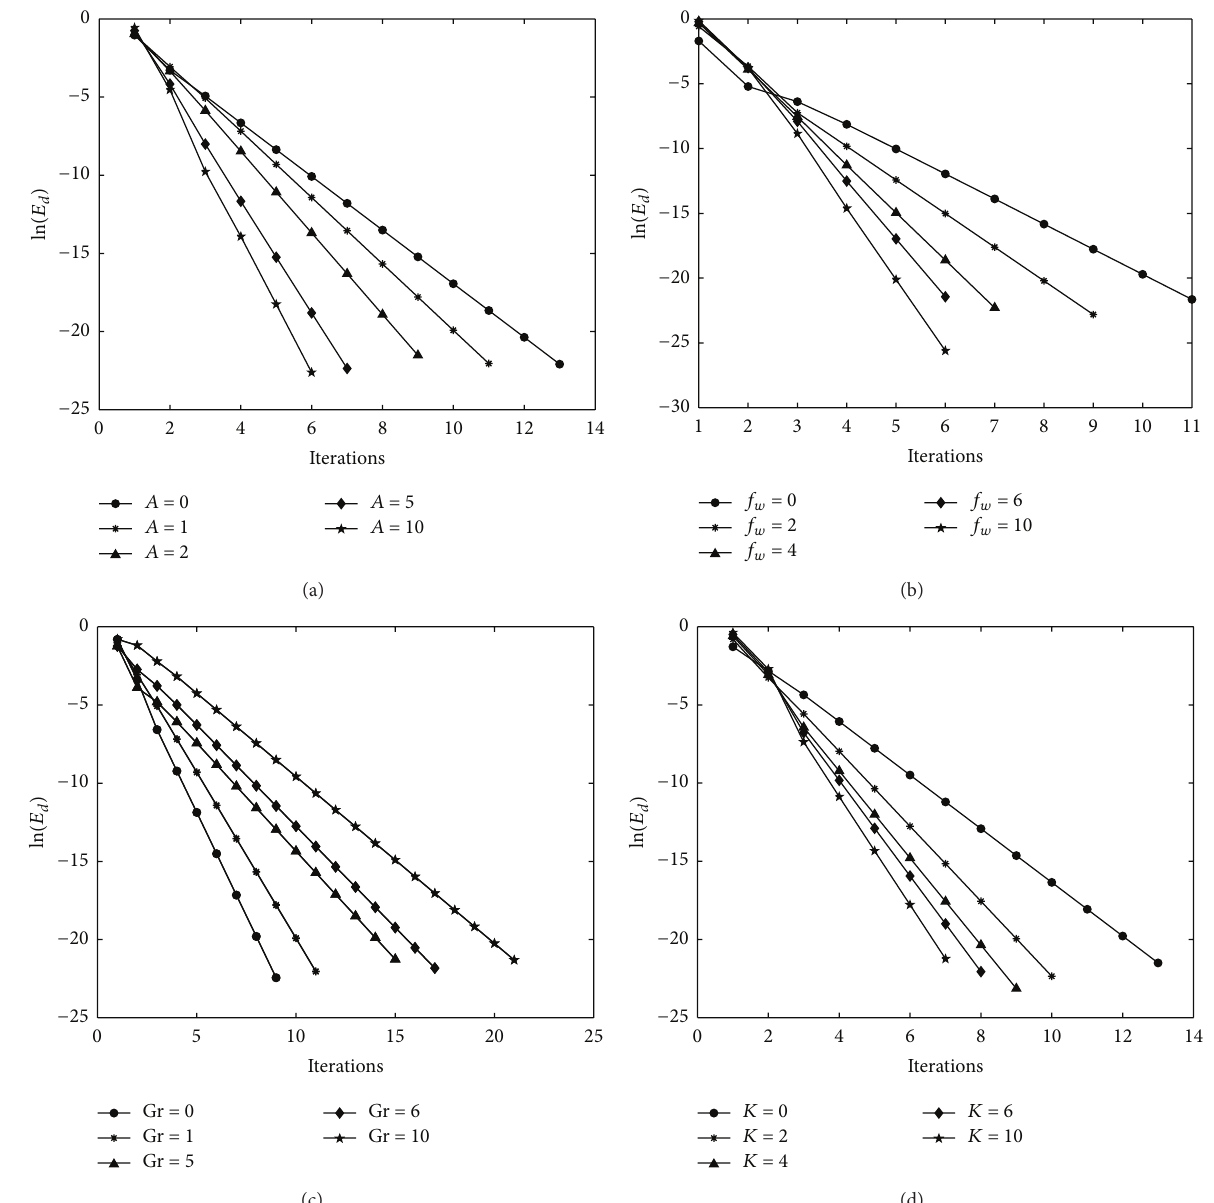
Figure 2: Effect of varying parameters on the Logarithm of the SLLM